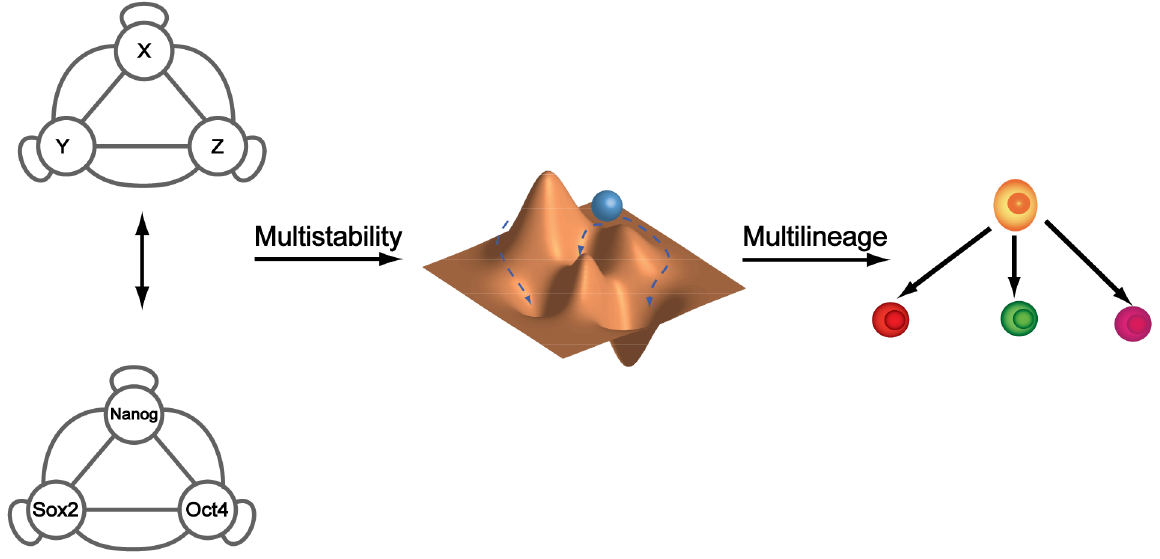
Figure 1. Multistability arises from small gene networks and underlies cell differentiation. Fully-connected triads (FCTs) are important, recurring transcriptional networks in the development and maintenance of cellular states. Notably, the Oct4-Sox2-Nanog triad has been implicated in inducing and maintaining stem cell pluripotency. In the Waddington model for cell differentiation [3], the cell’s underlying developmental landscape is governed by the dynamical potential of these small gene networks to realize multistability. Transition from one state to another can be guided via altered topology or strength of wiring.